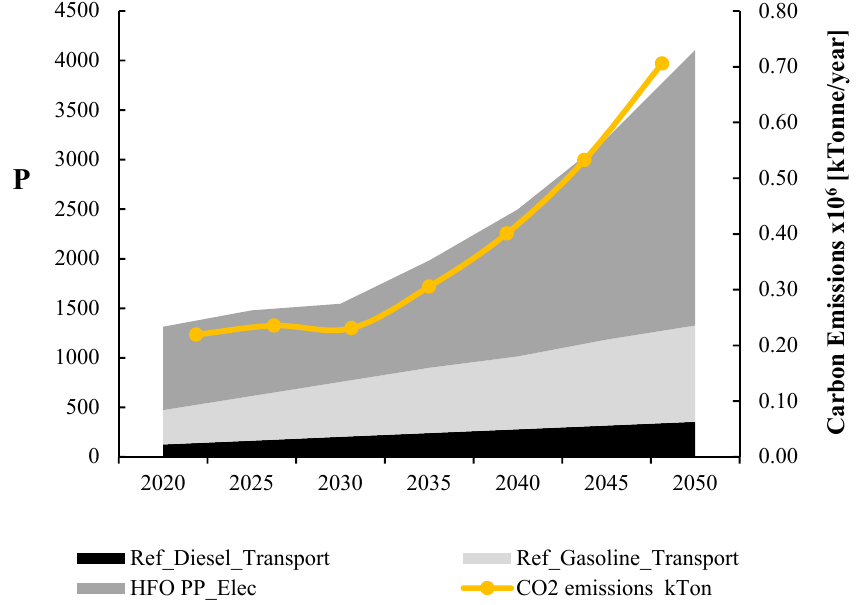
Figure 4. Energy / technology mix for Scenario 2 (CO 2 price $7.3 / tonne in 2015 rising at 5% annually with a ban on oil in power generation).